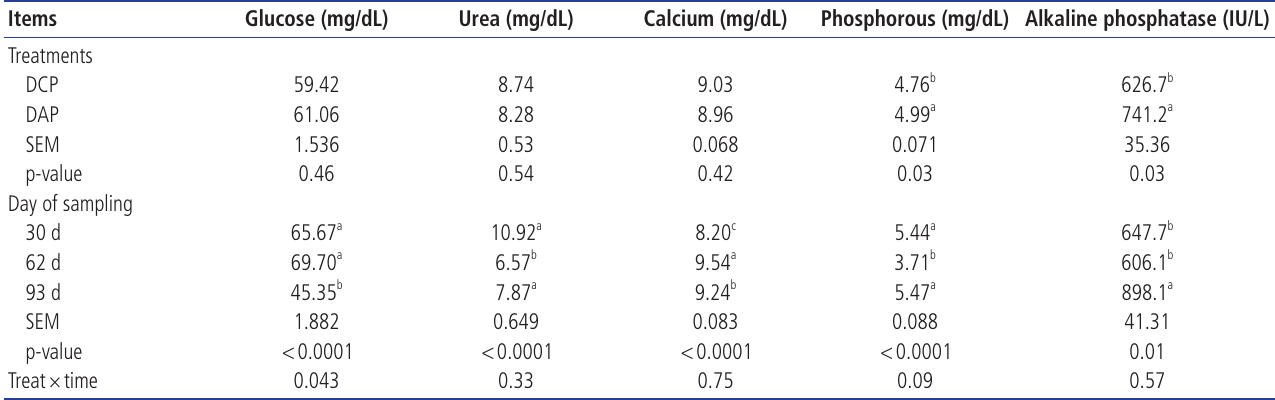
Table 5. Blood metabolite profile in finishing lambs fed a diet with either di-calcium phosphate (DCP) or di-ammonium phosphate (DAP) as a P source during 93 days